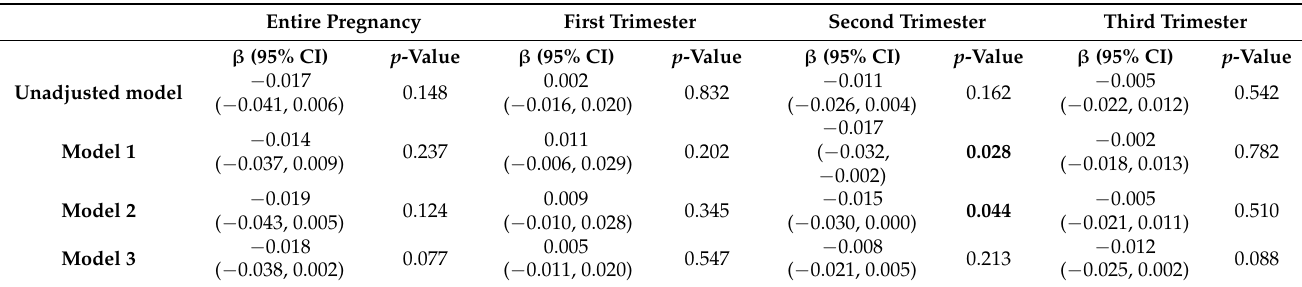
Table 4. Maternal dietary vitamin D intake during the first, second, and third trimester and entire pregnancy and average relative TL of the newborn.